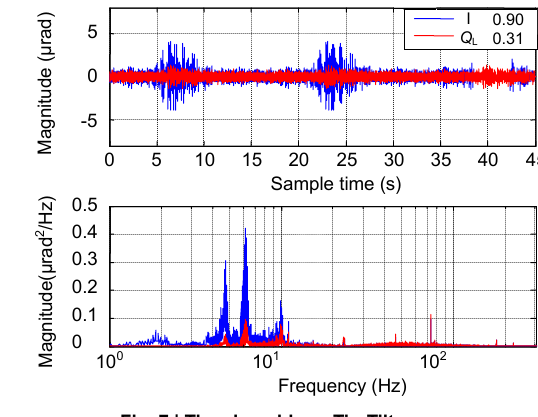
Fig. 7 | The closed-loop Tip-Tilt